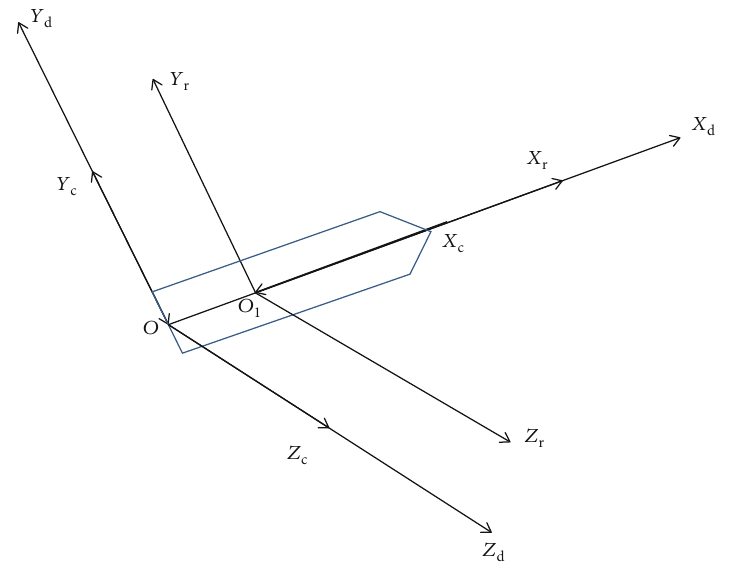
Figure 1: Installation method of